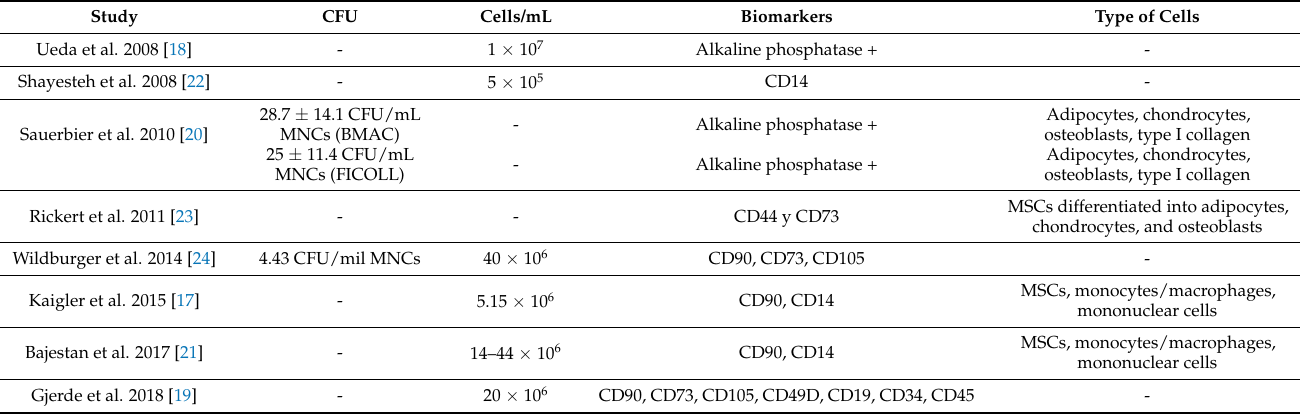
Table 4. Characteristics of cell